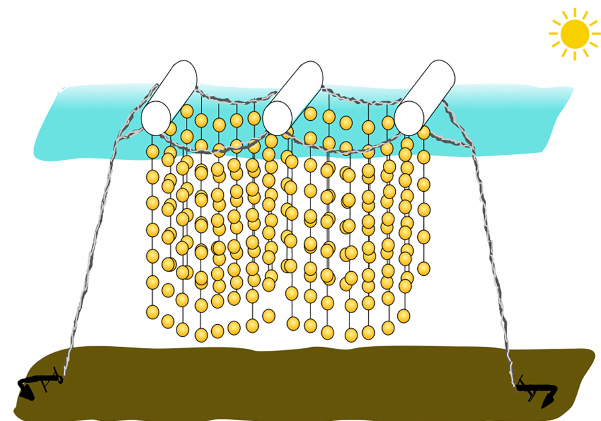
Figure 6. Aquaculture raft (long-line